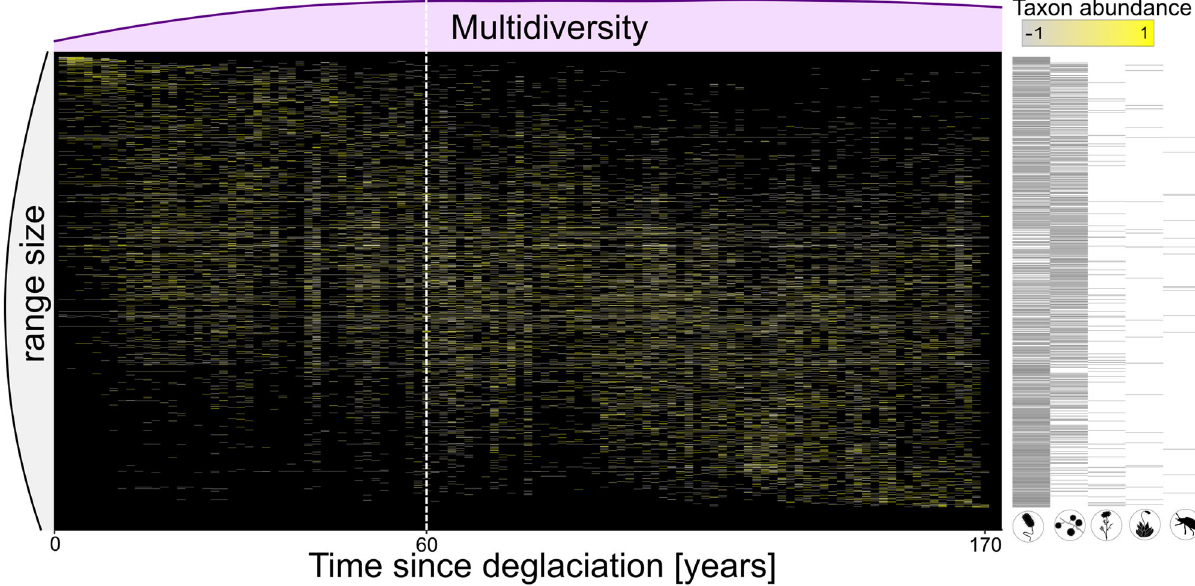
Fig. 2 Single taxa occurrence along the successional gradient for each taxon that occurs on at least three plots along the gradient. Tiles indicate the relative abundance of each taxon at a given plot relative to the mean abundance of the taxon along the gradient. Taxa are ordered by the weighted average plot of their occurrence, i.e., taxa that reach their abundance optima early in succession appear in the top left and late successional specialist in the bottom right. Relative taxon abundance is color-coded and re fl ects z-scores with the mean abundance as 0 and one standard deviation as + 1 or − 1, rescaled between − 1 and 1. Multidiversity is indicated as light pink density plot on top of the community composition plot. Grey density plot on the left side indicates the range size of the taxa, i.e., whether their occurrence is restricted to a narrow range of the successional gradient or whether taxa occur along the whole gradient. Black bars on the right represent the organismal group of the taxa in each row, symbols of organismal groups are ordered by decreasing frequency; white dashed horizontal line marks the